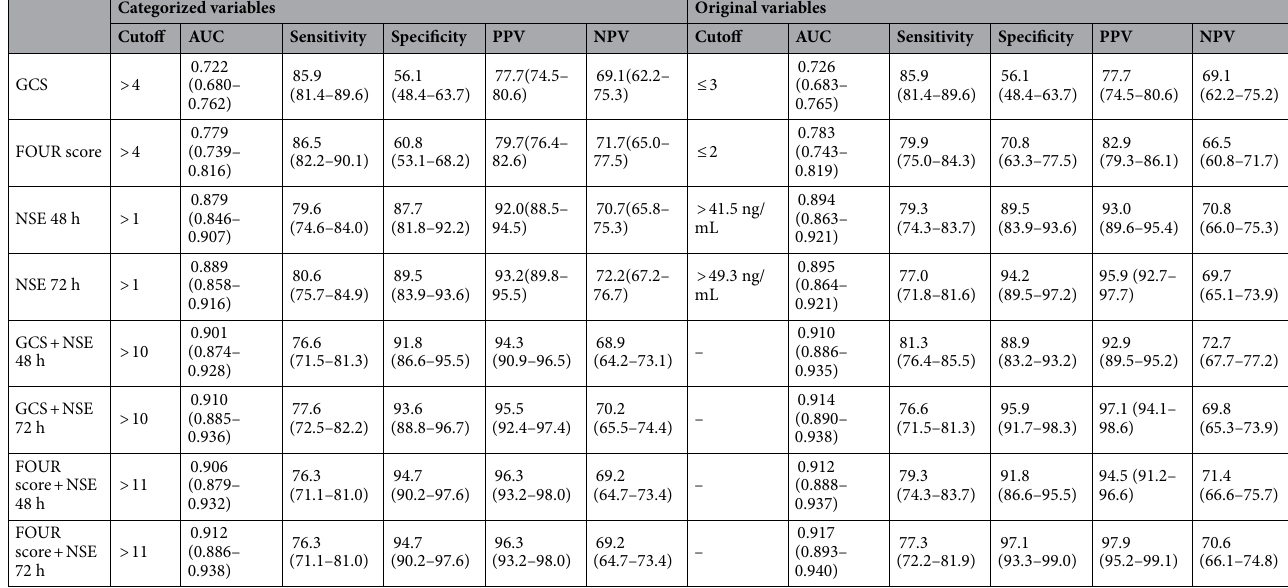
Table 3. Performance of neuron-specific enolase levels and neurologic scores for predicting neurological outcomes. AUC: area under the curve; PPV: positive predictive value; NPV: negative predictive value; GCS: Glasgow Coma Scale; FOUR: Full Outline of UnResponsiveness; NSE: neuron-specific